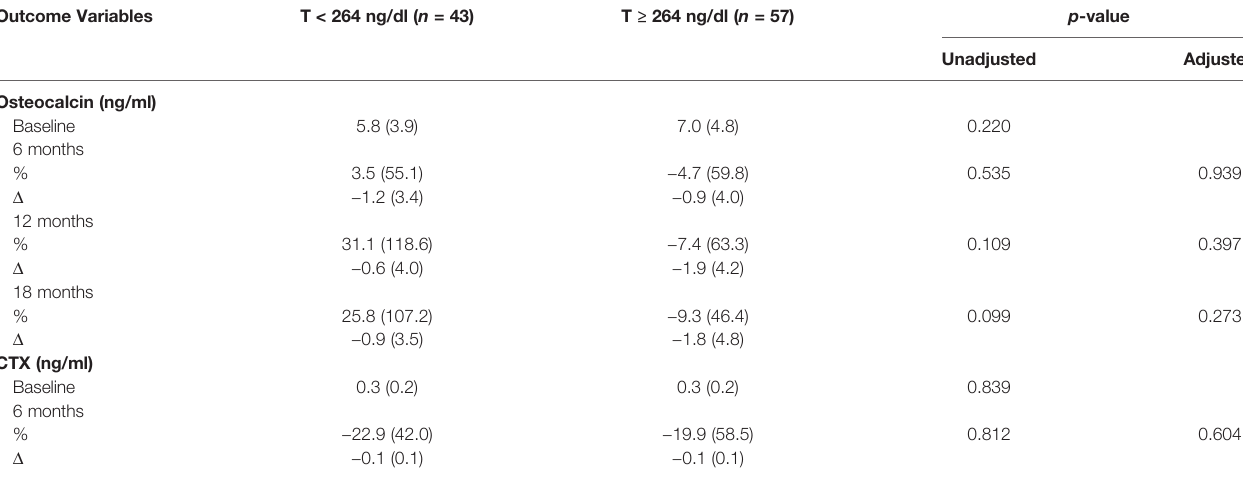
TABLE 5 | Changes in bone turnover markers with testosterone therapy from baseline to 18 months between the two groups. Outcome